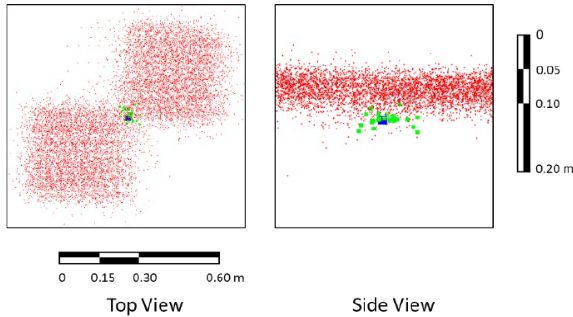
Figure 2. Qualitative evaluation of 3D alignment among LiDAR (red), image points (green), and GCP (blue) after calibration for checkerboard